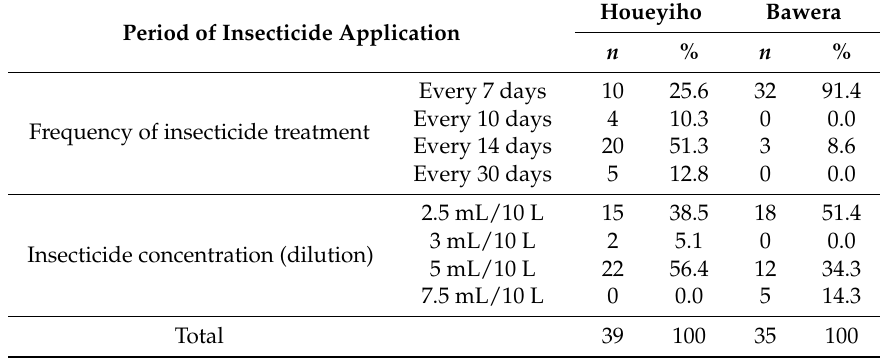
n : Number of respondents.